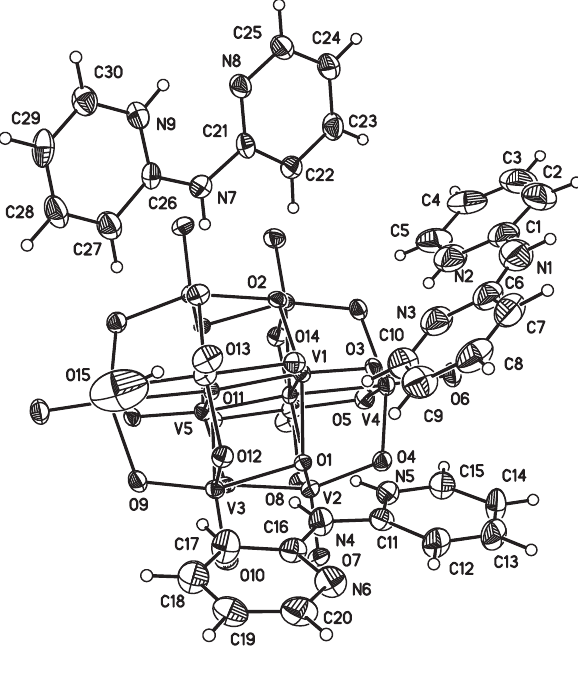
Table 1 contains crystallographic data and Table 2 contains the list of the atoms including atomic coordinates and displacement